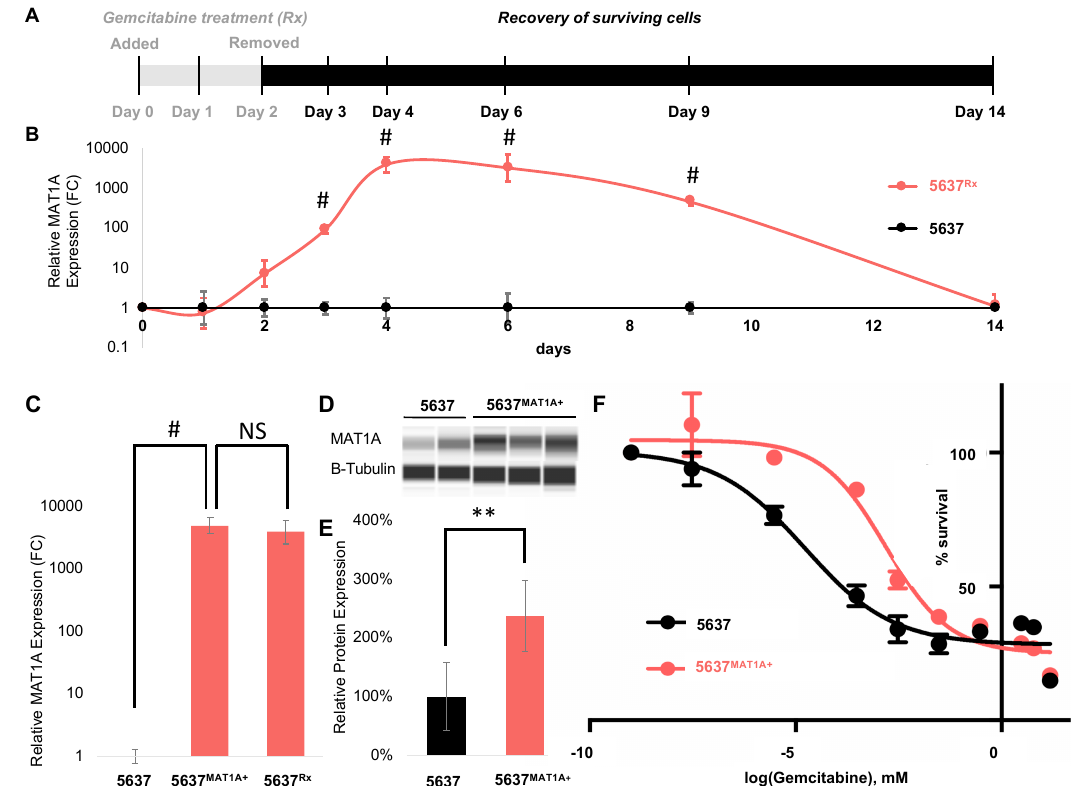
Figure 4. MAT1A is upregulated in cells that survive 48 h drug treatment and overexpression alters cell response to gemcitabine. ( A ) 5637 cells were dosed at ~80% IC50 gemcitabine concentration (0.3 µ M) for 48 h in vitro. RNA was collected from remaining gemcitabine treated (5637 Rx , n = 3) and untreated cells (5637, n = 3) before (day zero), during (day one, two) and after (day three, four, six, nine, and 12) drug treatment. ( B ) MAT1A expression was quantified via qPCR at each timepoint and expressed in FC. Statistical analysis was conducted using Student’s t-test, p < 0.0005 (#). ( C ) Quantitative PCR showing relative MAT1A gene expression in MAT1A plasmid transfected 5637 bladder cancer cells (5637 MAT1A + ) expressed as FC, ( n = 3 biological replicates), p < 0.0005 (#) compared to expression at day four in post drug treated 5637 cells (5637 Rx ) (NS, non-significant). ( D ) Representative gel of MAT1A protein expression relative to control b-tubulin analyzed via Western blotting using the Jess system (ProteinSimple). ( E ) Normalized MAT1A / b-tubulin protein expression calculated using Jess system densitometry expressed as percent of wildtype MAT1A expression in 5637 control cells ( n = 6 biological replicates), p < 0.005 (**). ( F ) IC50 gemcitabine drug toxicity curve between empty vector transfected and MAT1A transfected cells ( n = 5 biological replicates per condition per dose).